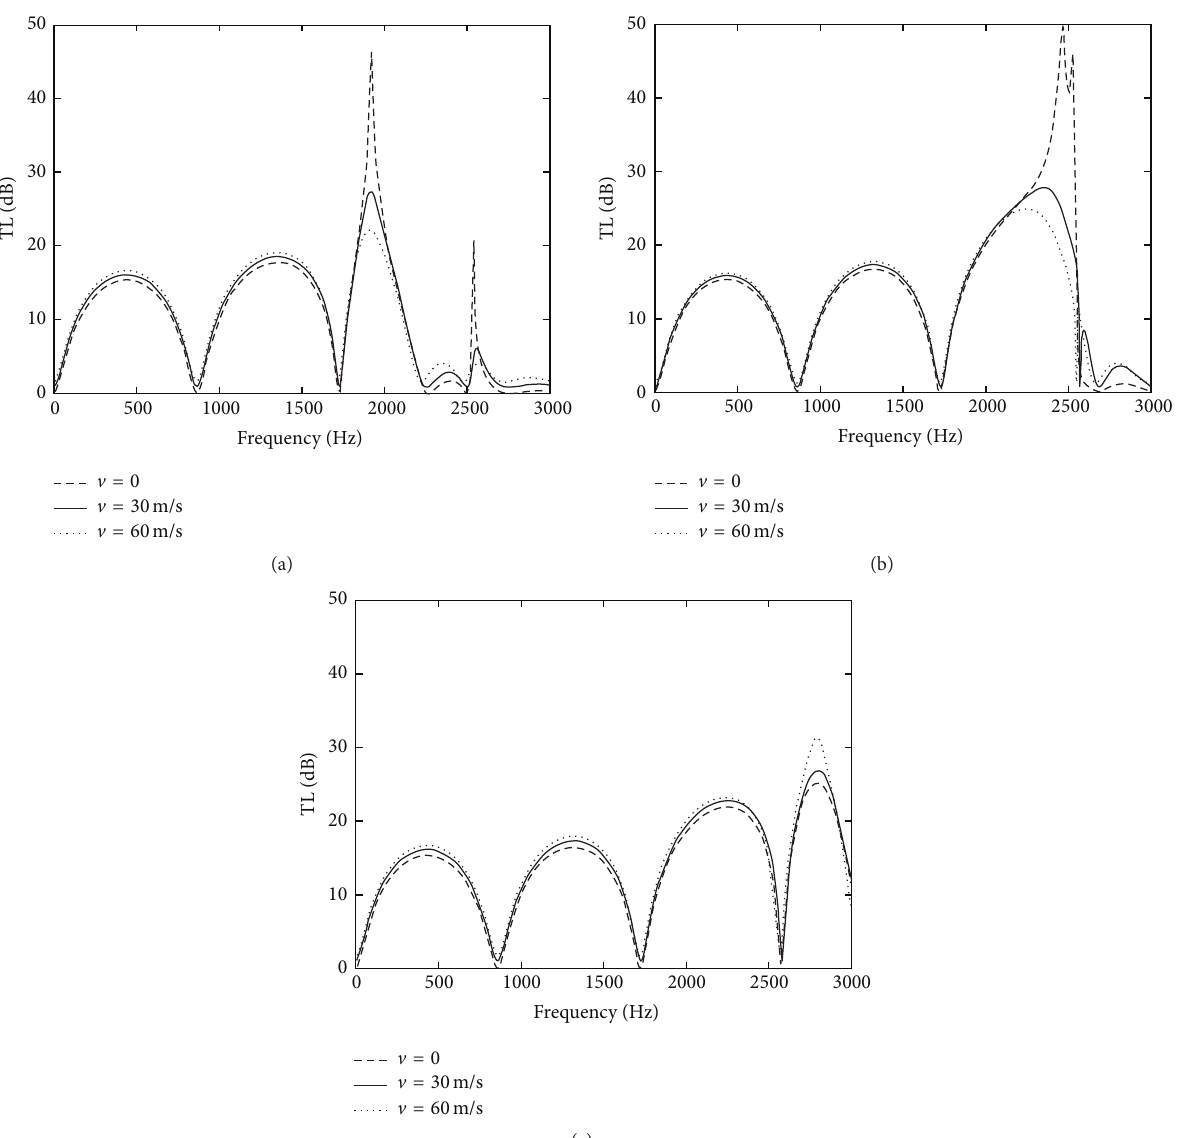
are employed to perform the steady flow computation and acoustic response analysis, respectively. The data transfer is accomplished by mesh mapping. A comparison between present results and previously published experimental and numerical results indicates that the present 3D numerical method is capable of delivering reasonable predictions.